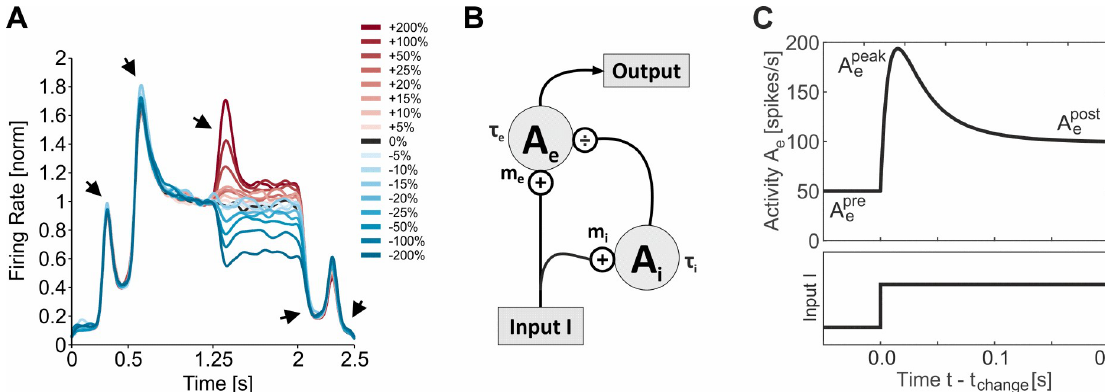
Fig 1. Transient responses in area MT and model circuit. (A) Population response of 94 MT neurons exhibiting large transients (black arrows) in response to stimulus onset (at t = 0.25 s), movement onset (at t = 0.5 s), speed change (at t = 1.25 s), movement offset (at t = 2.0 s) and stimulus offset (at t = 2.25 s). Color scale indicates sign and magnitude of the speed change (blue for decelerations, red for accelerations). Speed change magnitudes are given in Weber fractions, i.e. with the lower speed as the reference. Modified from [7]. (B) Model circuit providing divisive inhibition A i to an MT neuron with activation A e . τ e and τ i denote time constants and m e and m i denote gains of the corresponding units. (C) Example response of the model circuit (upper graph) to a positive input change at time t (lower graph). change ¼ 50 spikes/s, the circuit exhibits a fast transient increase in activation reaching a peak response A peak Starting from activation level A pre e e before decreasing more slowly to a post-change, sustained activation level A post ¼ 100 spikes/s (with parameters: τ = 10 ms, τ = 40 ms, e i e ¼ 120 A max e